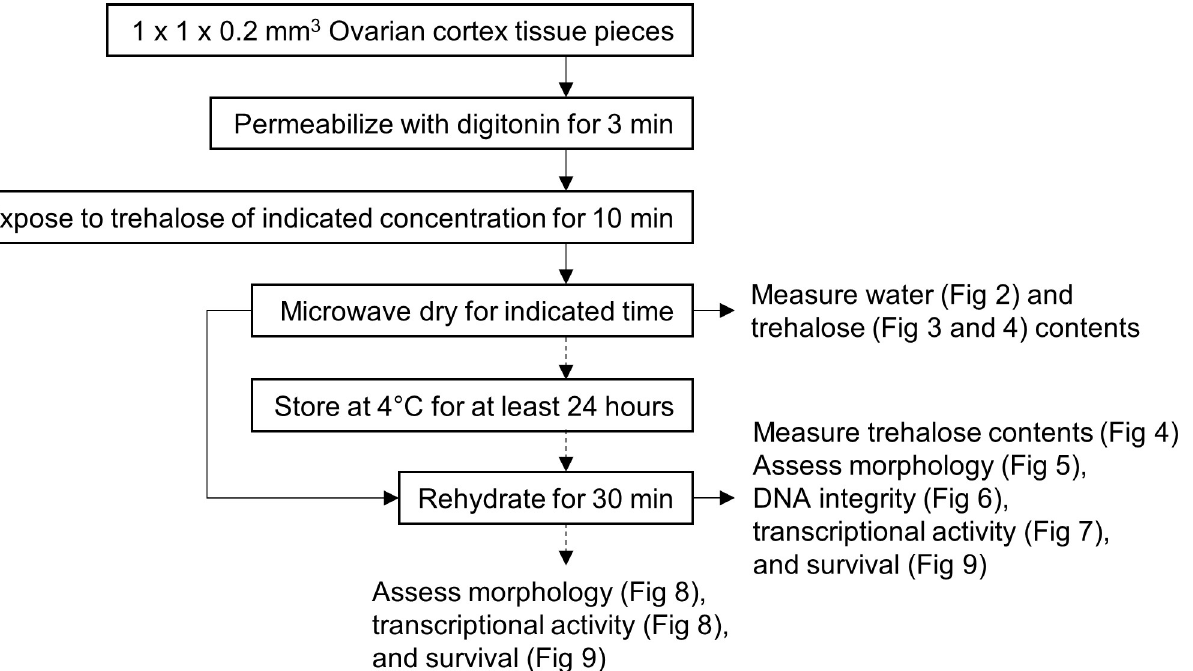
PLOS ONE | https://doi.org/10.1371/journal.pone.0225440 December4,